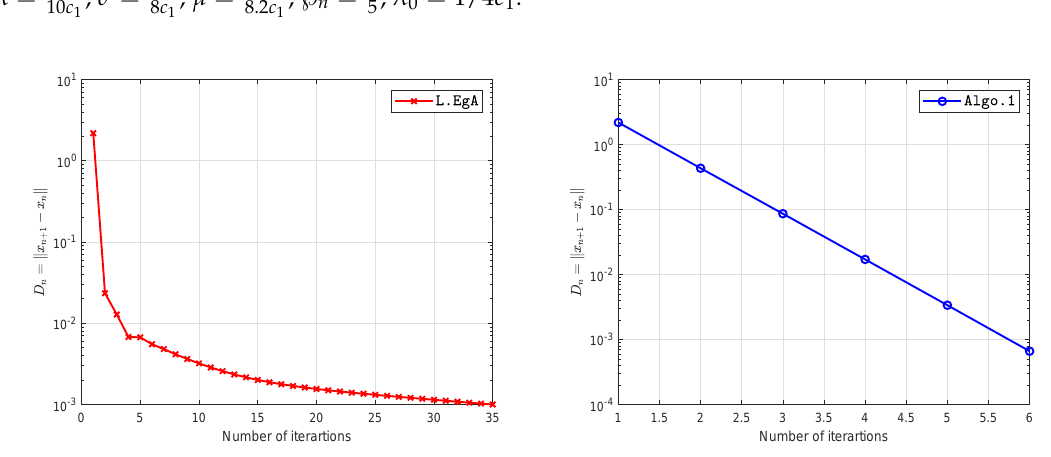
Figure 5. Example 2 for average number of iterations while n = 5.